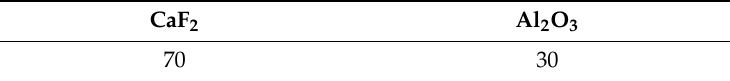
Table 2. Compositions of the slag, wt%.